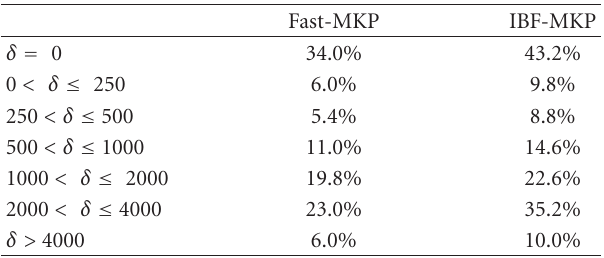
Table 2: Comparison of the “requests scale-down” between the algorithms.